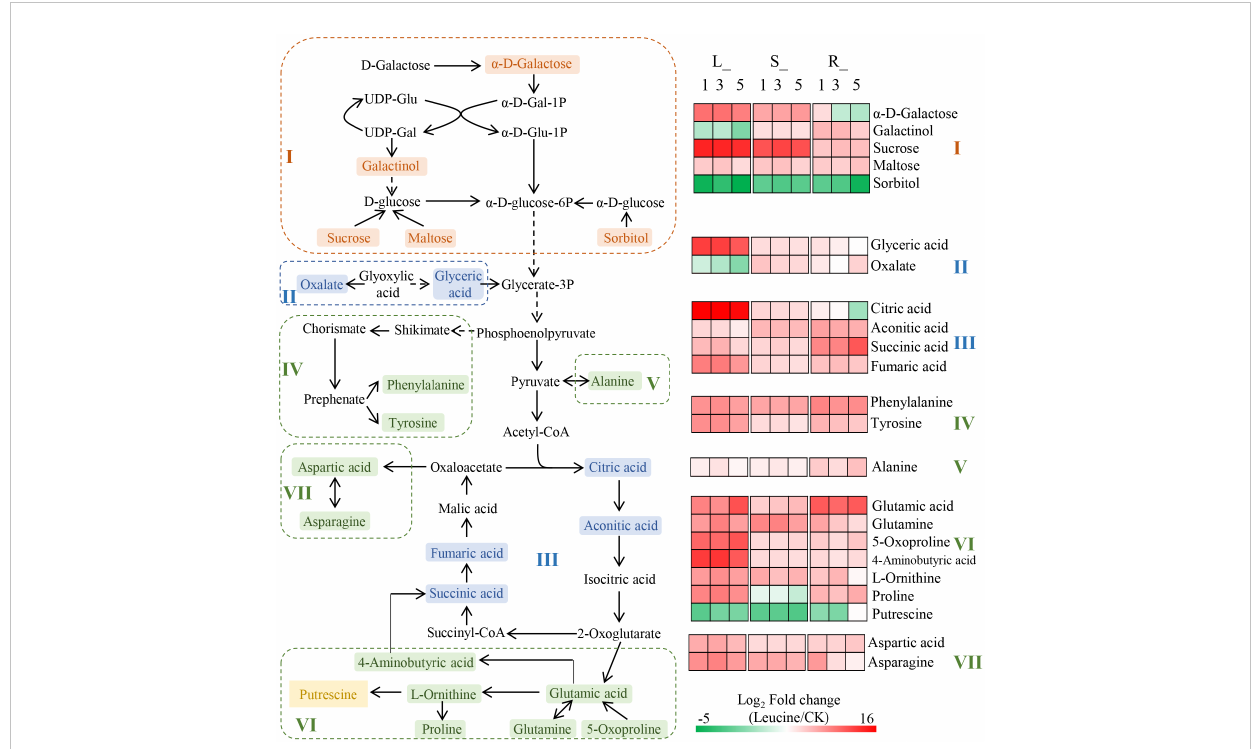
FIGURE 4 KEGG metabolic network analysis of the pathways in the leaves, stems and roots. Parts I, II and III are the decomposition of disaccharides or monosaccharides in glycolysis and then in fl ux into the TCA cycle. Parts IV, V, VI and VII are amino acid biosynthesis metabolism pathways using the intermediate products of glycolysis and the TCA cycle as precursors. DAMs shown in orange, blue, green and yellow represent sugars and derivatives, organic acids, amino acids and polyamines, respectively. The colour block represents the fold changes (leucine/CK) after log 2 conversion; red represents upregulation, and green represents